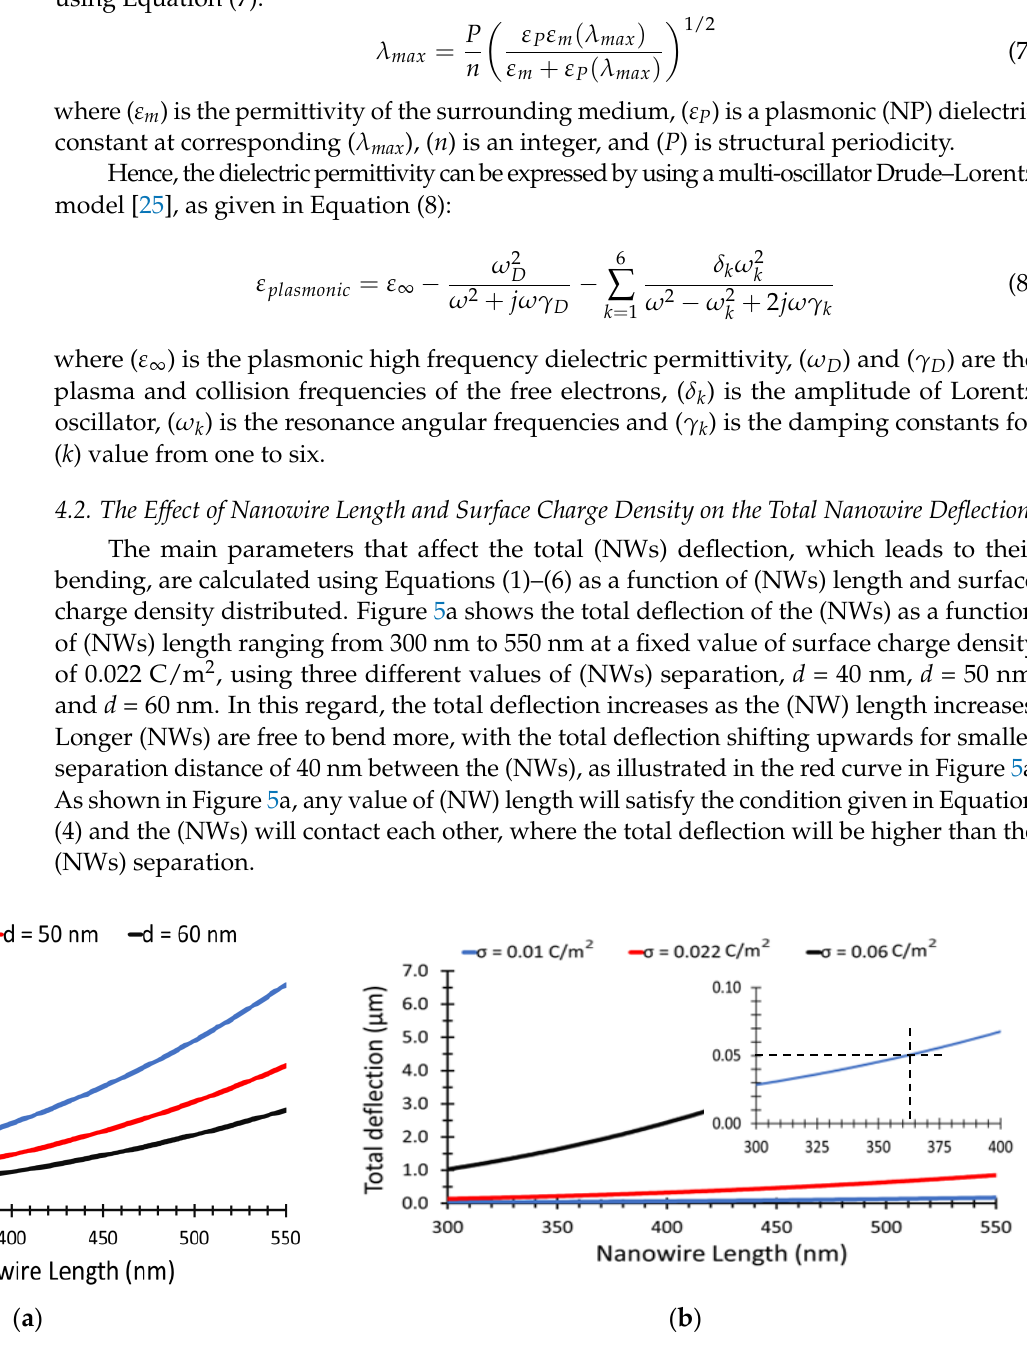
Figure 5. Total deflection versus NWs length ( a ) for different NWs separations, ( b ) for different surface charge density.